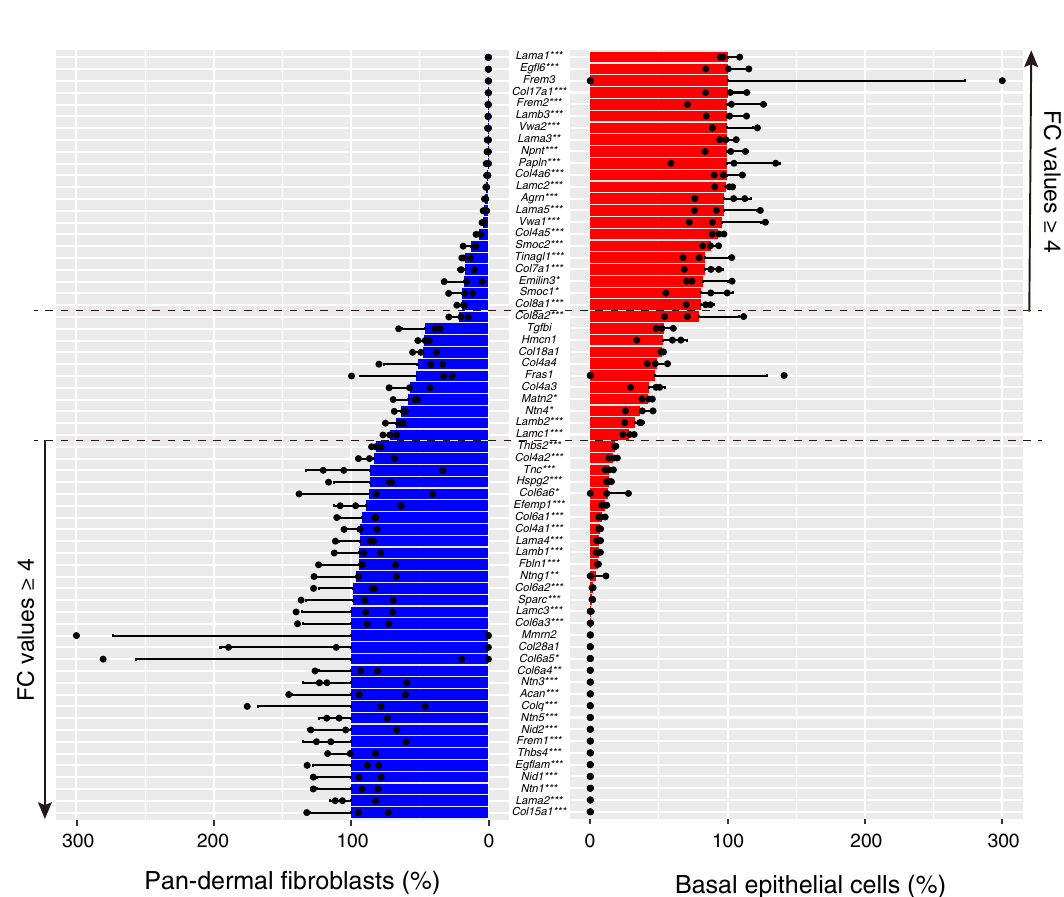
Fig. 1 Targeted cell isolation and transcriptional pro fi ling of mouse hair follicle. a Graphical illustration of adult telogen HF compartments. Grey and black frames indicate epithelial and dermal compartments targeted in this study, respectively. IFE interfollicular epidermis. APM arrector pili muscle. b – g Tissue distribution of the markers for each HF compartment. Brackets indicate the target cell compartment in each panel. HF mid-bulge basal stem cells were labelled with α 6 integrin (green) and CD34 (red) ( b ). Lower isthmus epithelial basal stem cells were visualized by Lgr6 -eGFP (green) ( c ). Upper bulge epithelial basal stem cells were visualized by Gli1 -eGFP (green) ( d ). HG cells were visualized by Cdh3 -eGFP (green) ( e ). Dermal papilla (DP) cells and arrector pili muscles (arrowheads) were visualized by Lef1 -eGFP (green) ( f ). Dermal fi broblasts (arrowheads), including DP cells, were visualized by Pdgfra - H2BeGFP (green) ( g ). White dashed lines indicate epithelial – dermal borders. Scale bar, 30 μ m. h Relative mRNA expression levels of HF region-speci fi c genes in different sorted cell populations. mRNA levels are expressed relative to Gapdh and represented by Z -score values. Numbers of biological replicates for each sample group are indicated in the sample names. i Global ECM gene expression correlation among HF cell populations examined by Spearman ’ s rank correlation coef fi cient analysis. Each cell represents overall transcriptomic expression similarity between a pair of samples with a range from − 1 to 1. All genes, matrisome genes, non-matrisome genes, basement membrane (BM) genes and interstitial ECM genes are used. Values of each biological replicate are presented in these heatmaps. Numbers of biological replicates are indicated in the ‘ All genes ’ panel.